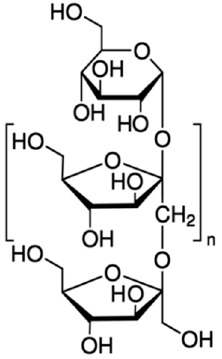
Figure 1. Chemical structure of inulin.